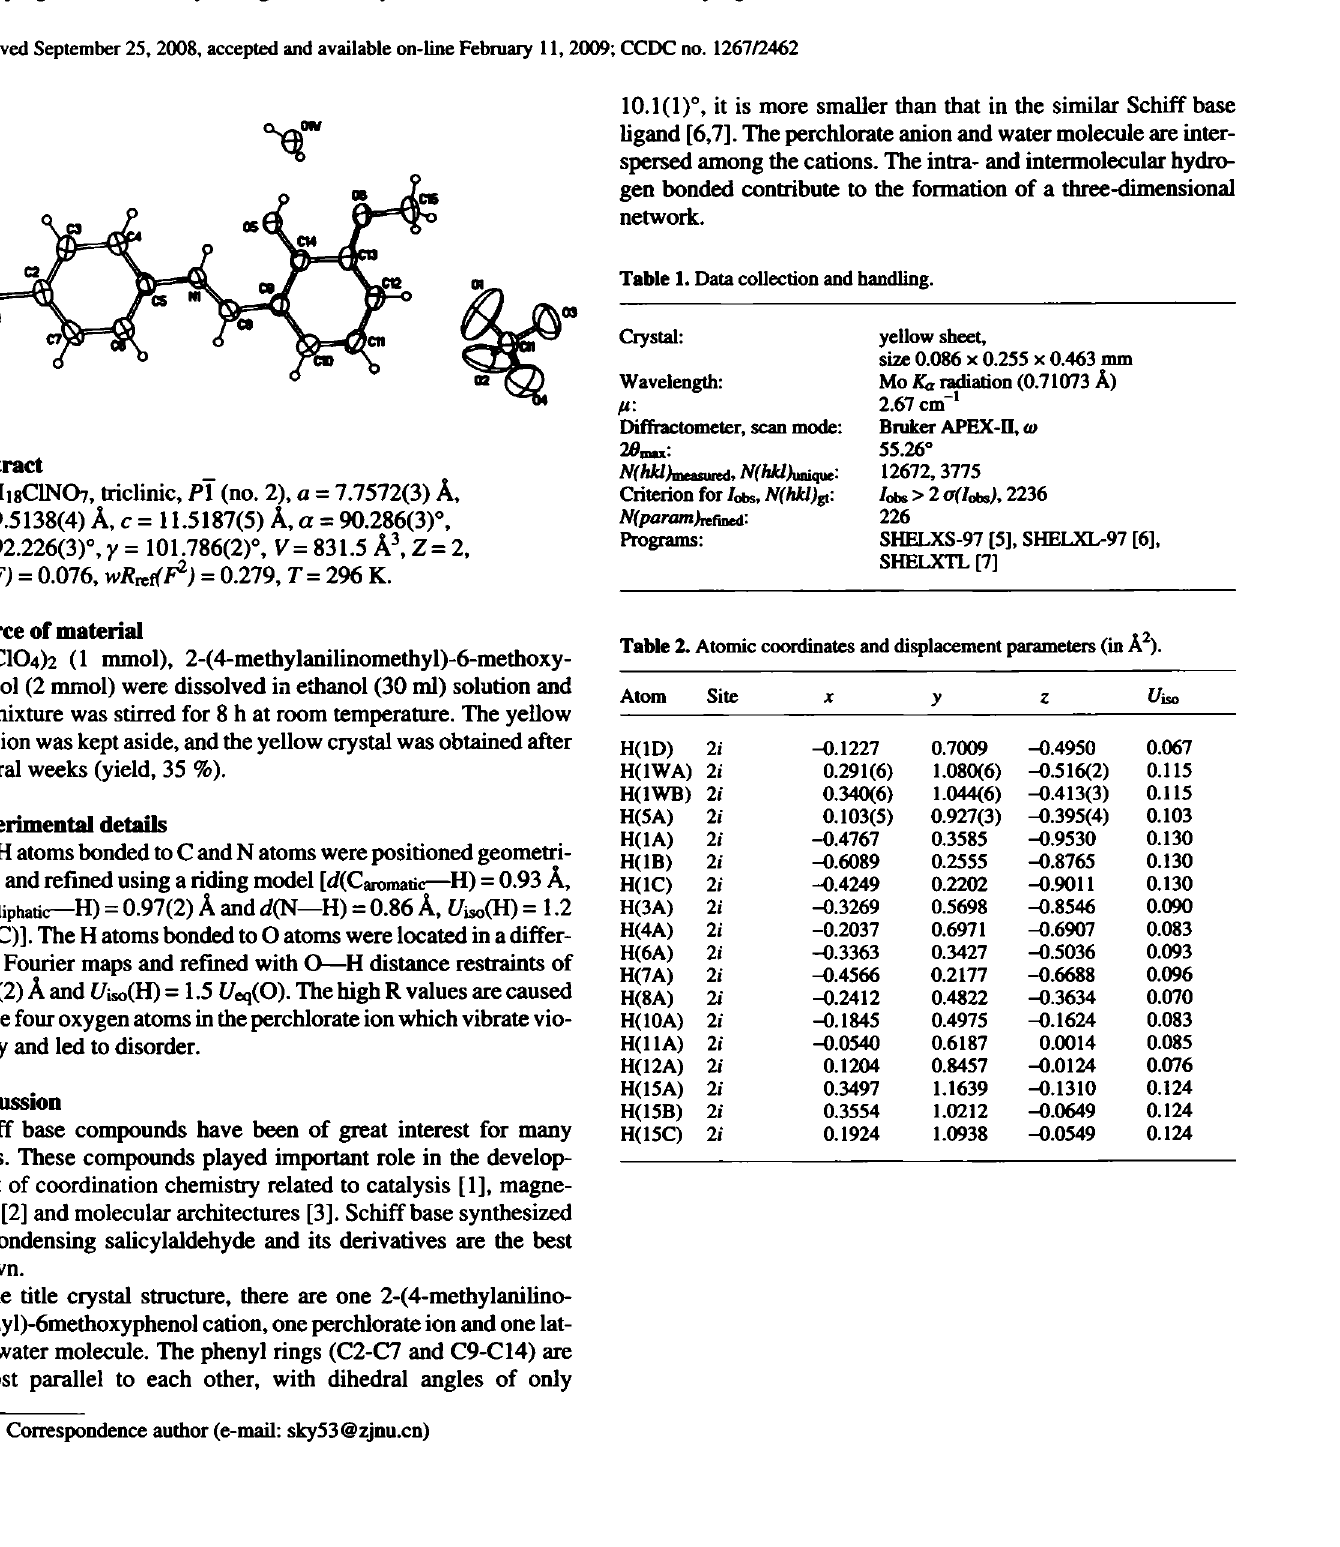
Table 2. Atomic coordinates and displacement parameters (in Â 2